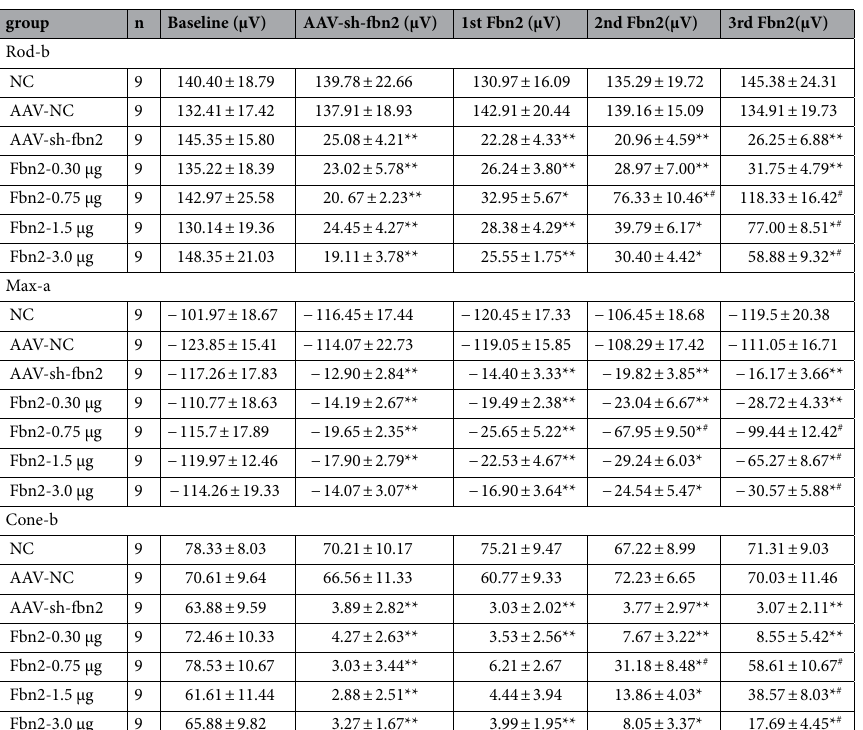
Table 1. Retinal electroretinogram measurements (mean ± standard deviation). Rod-b, Rod b-wave amplitude (dark adaptation 0.01 ERG). Max-a, the maximal a-wave (dark adaptation 3.0 ERG). Cone-b, Cone b-wave amplitude (light adaptation 3.0 ERG). NC, Animals without intervention. AAV-NC group, Animals with an intravitreal injection of AAV empty vector and without any further treatment. AAV-sh-fbn2, Animals with an intravitreal injection of AAV-sh-fbn2 and without any further treatment. Fbn2-0.30 μg, Animals with an intravitreal injection of AAV-sh-fbn2, followed by an intravitreal injection of fbn2 recombinant protein in a dose of 0.30 μg. Fbn2-0.75 μg, Animals with an intravitreal injection of AAV-sh-fbn2, followed by an intravitreal injection of fbn2 recombinant protein in a dose of 0.75 μg. Fbn2-1.5 μg, Animals with an intravitreal injection of AAV-sh-fbn2, followed by an intravitreal injection of fbn2 recombinant protein in a dose of 1.50 μg. Fbn2-3.0 μg, Animals with an intravitreal injection of AAV-sh-fbn2, followed by an intravitreal injection of fbn2 recombinant protein in a dose of 3.00 μg. * P < 0.05 compared with the AAV-NC group; ** P < 0.001 compared with the AAV-NC group; # P < 0.05 compared with the AAV-sh-fbn2 group; ## P < 0.001 compared with the AAV-sh-fbn2